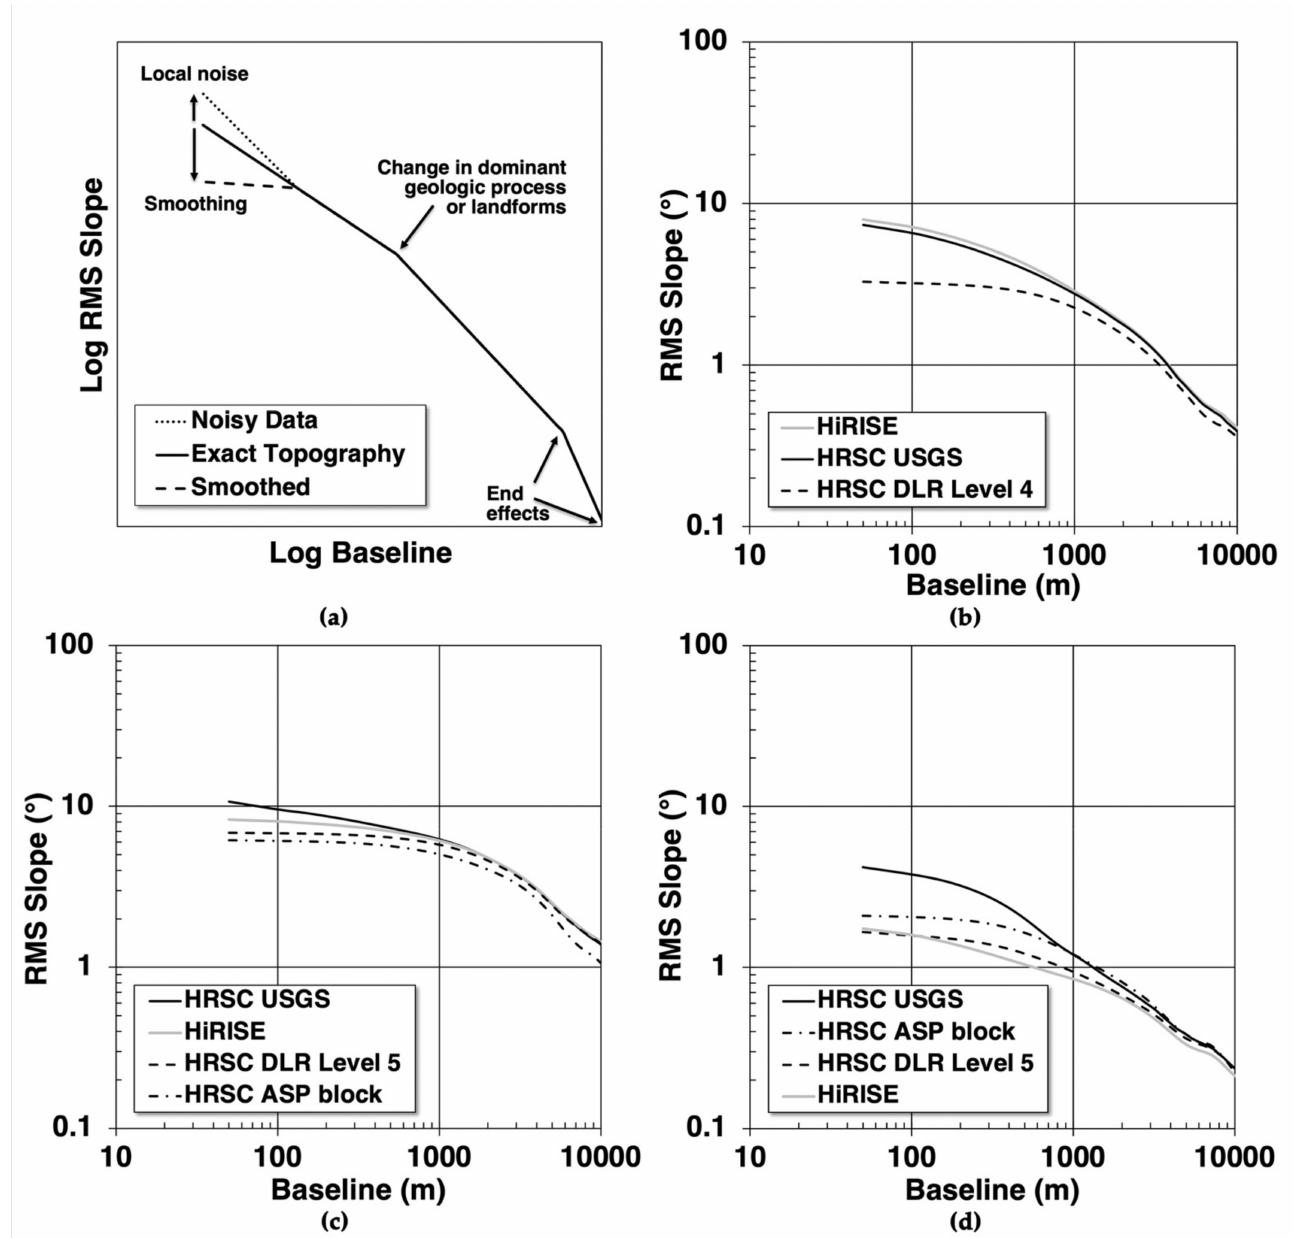
Figure 12. RMS bidirectional slope as a function of baseline. ( a ) Schematic effects. ( b ) Gale data from [11]. ( c ) Data for Jezero crater rim area. ( d ) Data for Jezero crater floor. Data in c and d come from rectangular subareas within the red and green areas outlined in Figure 2,